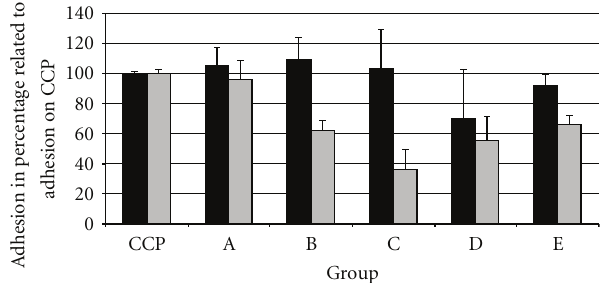
Figure 2: Adherent cells after 24 h (black) and 72 h (grey) of incubation relative to reference plastic (CCP = cell culture plastic; A = nonhexylated polymer; B = hexylated polymer; C = hexylated polymer spin coated with amorphous silicon dioxide; D = hexylated polymer spin coated with nanoblown silicon dioxide; E = untreated